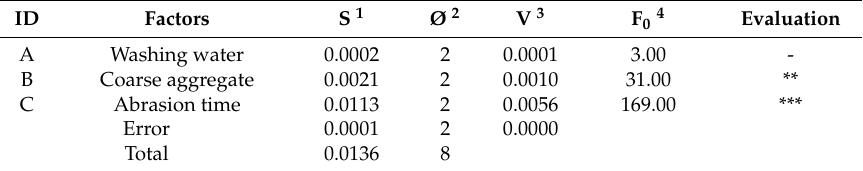
Table 6. Variance analysis for density of recycled fine aggregate.